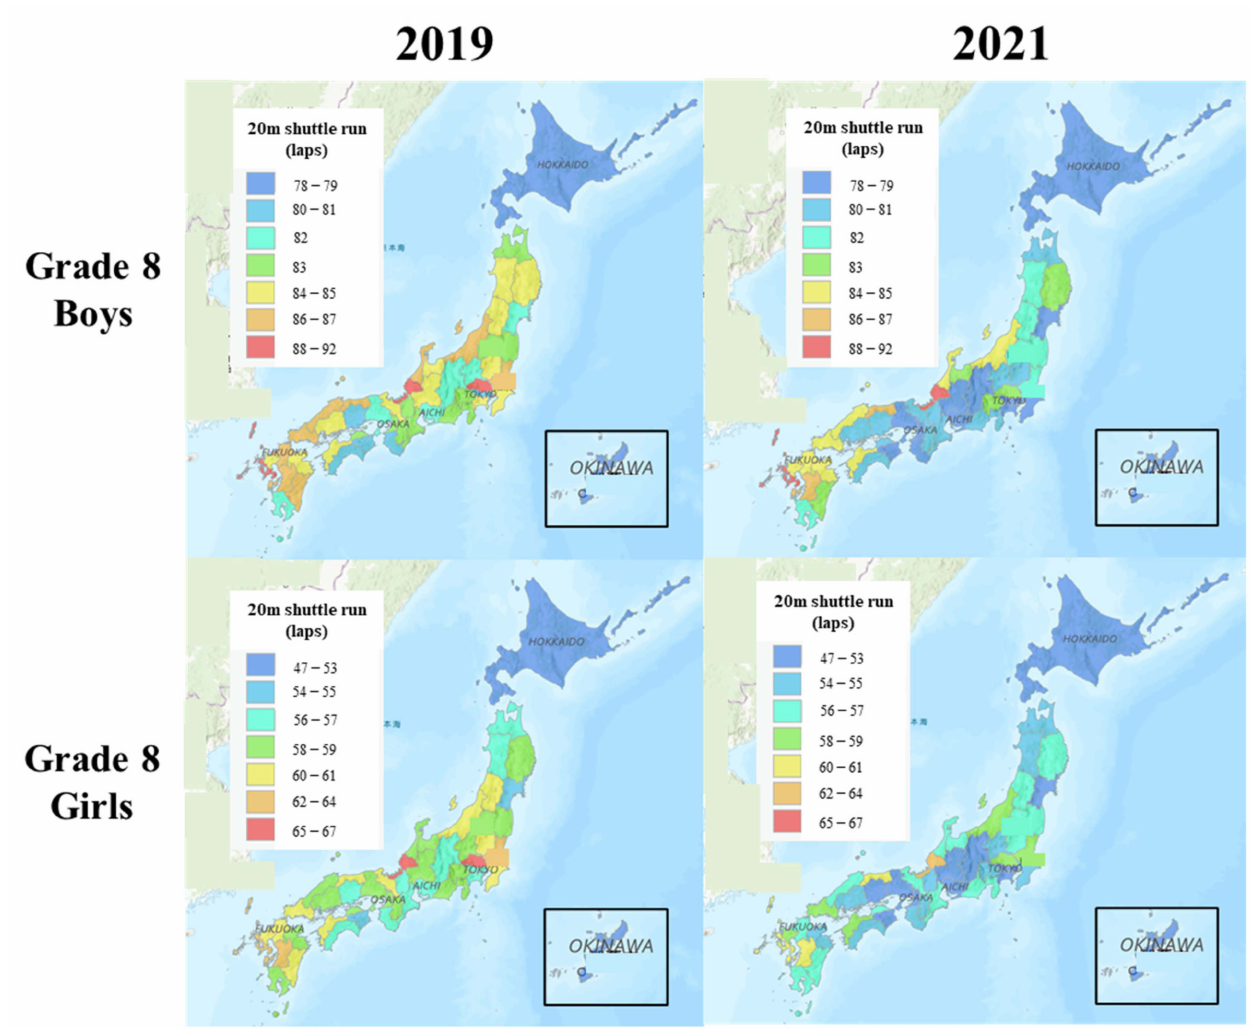
Figure 3. CRF landscapes for Grade 8 students in 2019 and